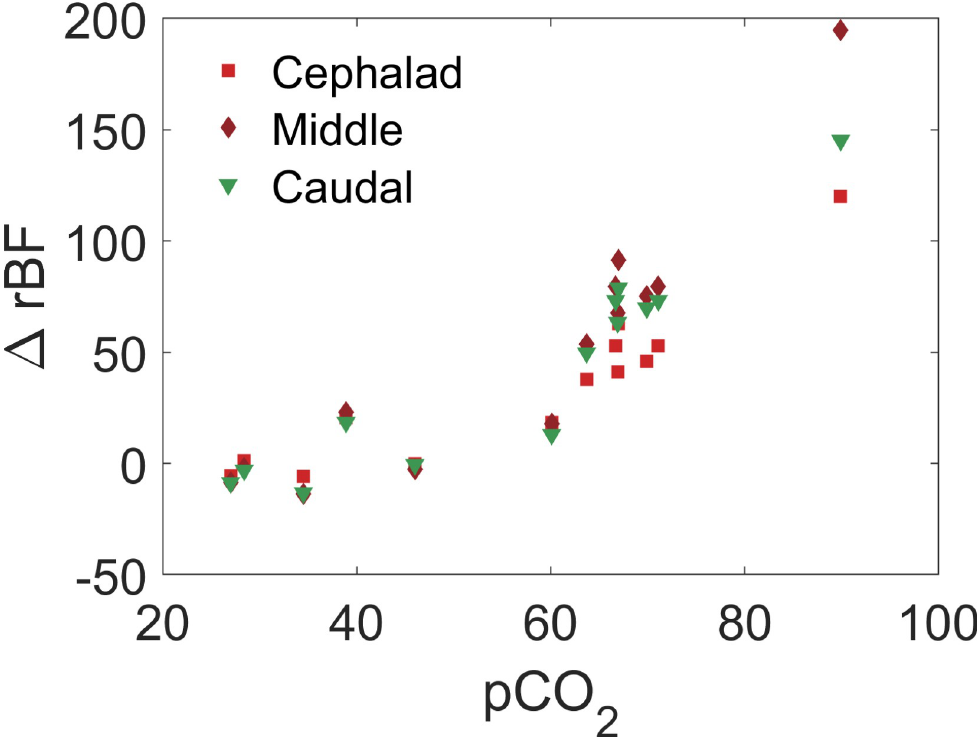
Fig 4. Example change in relative blood flow versus blood concentration of carbon dioxide measured by DCS at three sites along the spinal cord in a single pig.